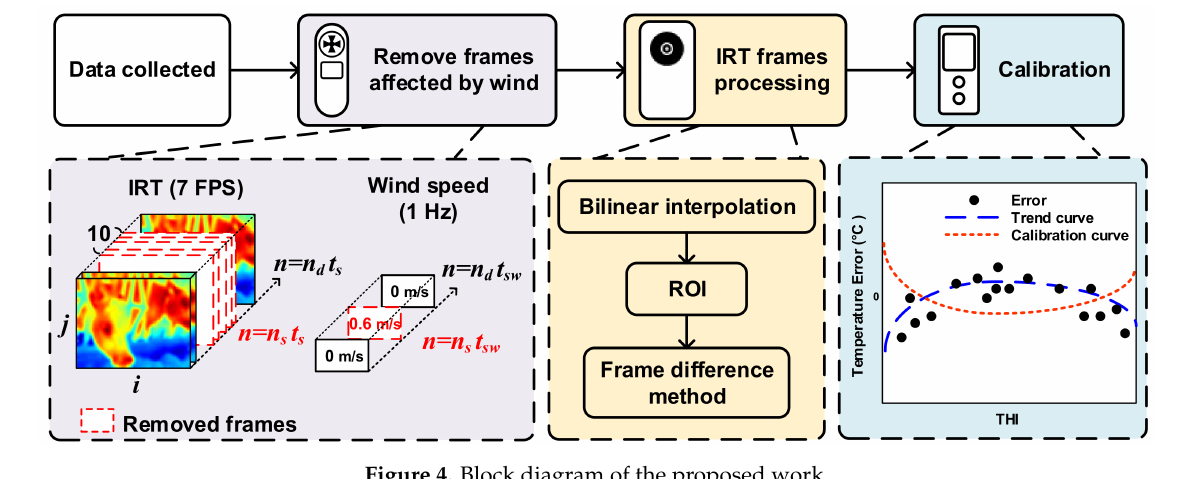
Figure 4. Block diagram of the proposed work.